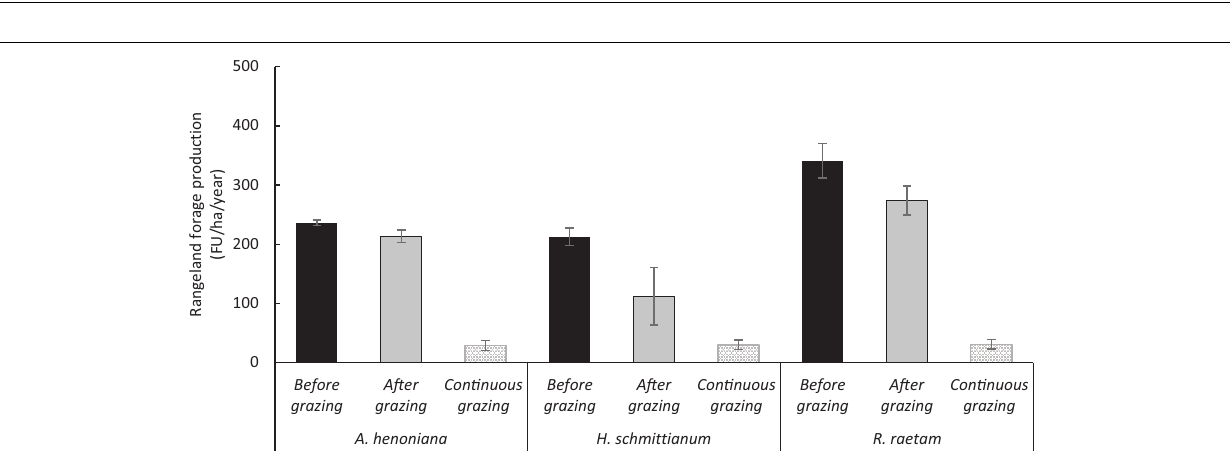
FIGURE 4 | Rangeland forage productivity (FU/ha/year) in 2 years protected plant communities ( A. henoniana, H. schmittianum , and R. raetam ) sites before and after subjecting to 1 week of intense grazing compared to continuous grazing sites in Tataouine, Tunisia.